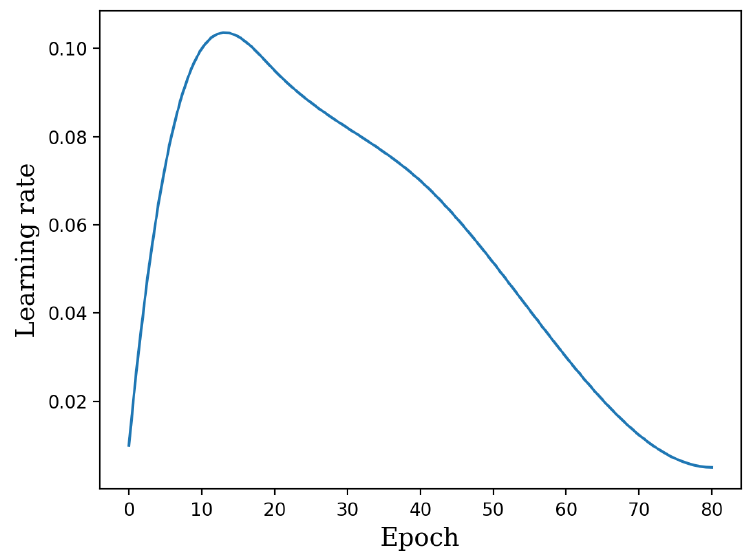
Figure 12. Trends in learning